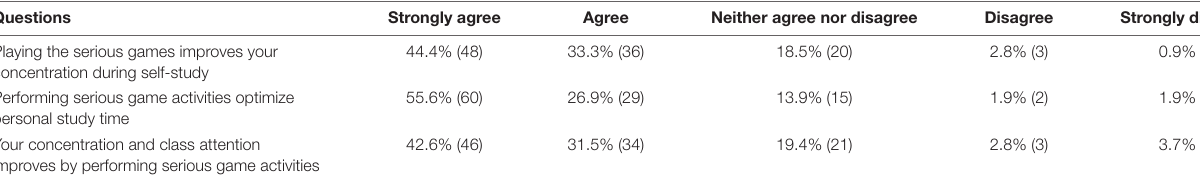
TABLE 2 | Percentage of responses to questions on self-efficacy.